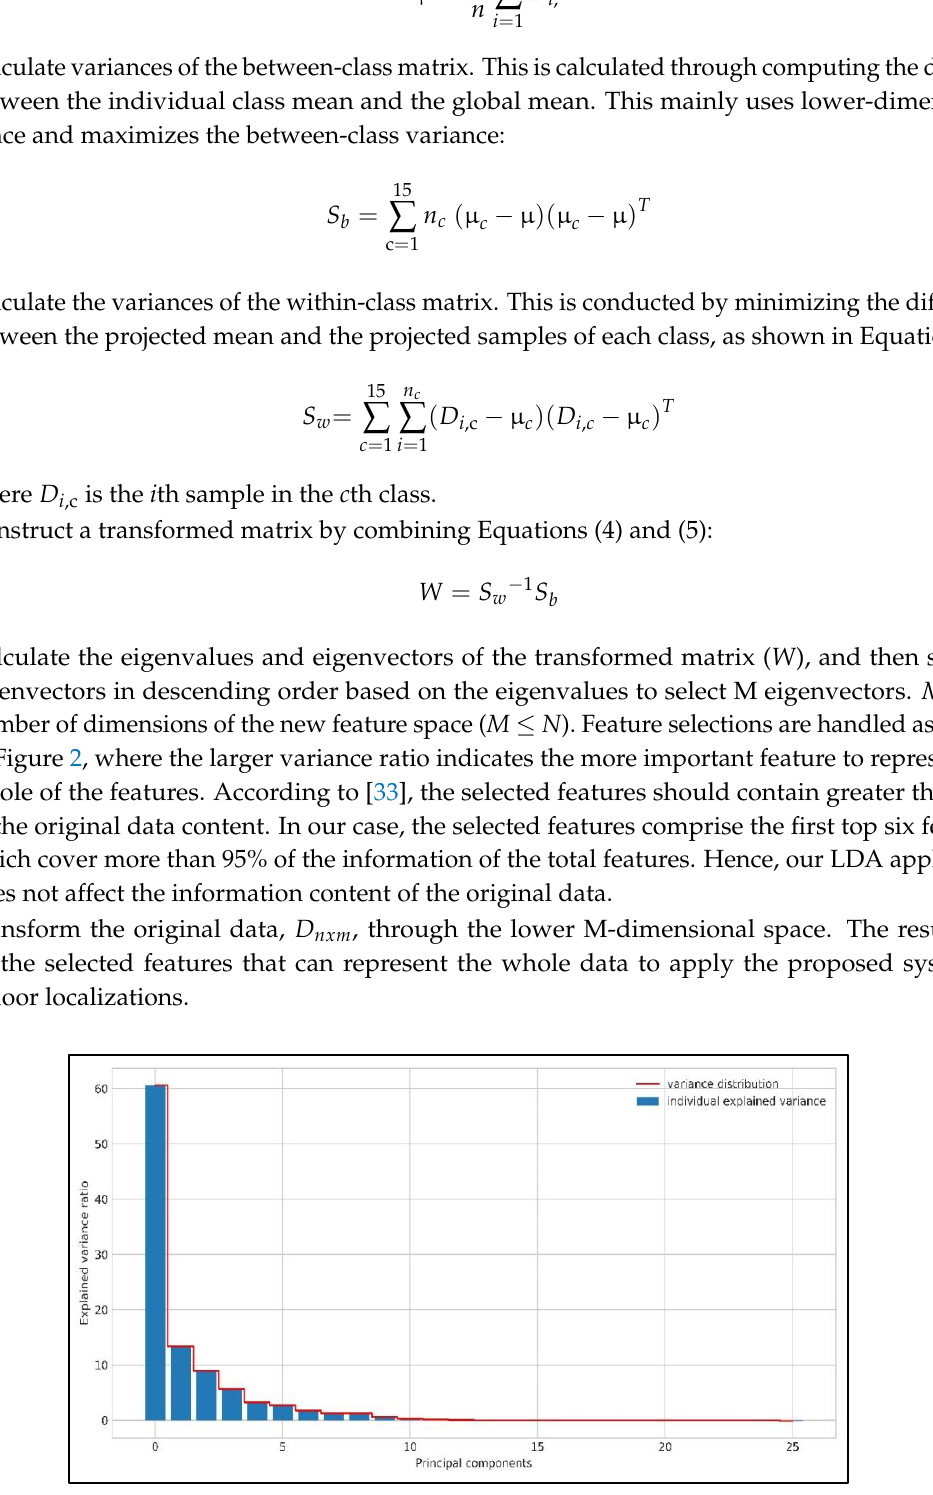
Figure 2. Feature distributions for linear discriminant analysis (LDA)-based feature selections.